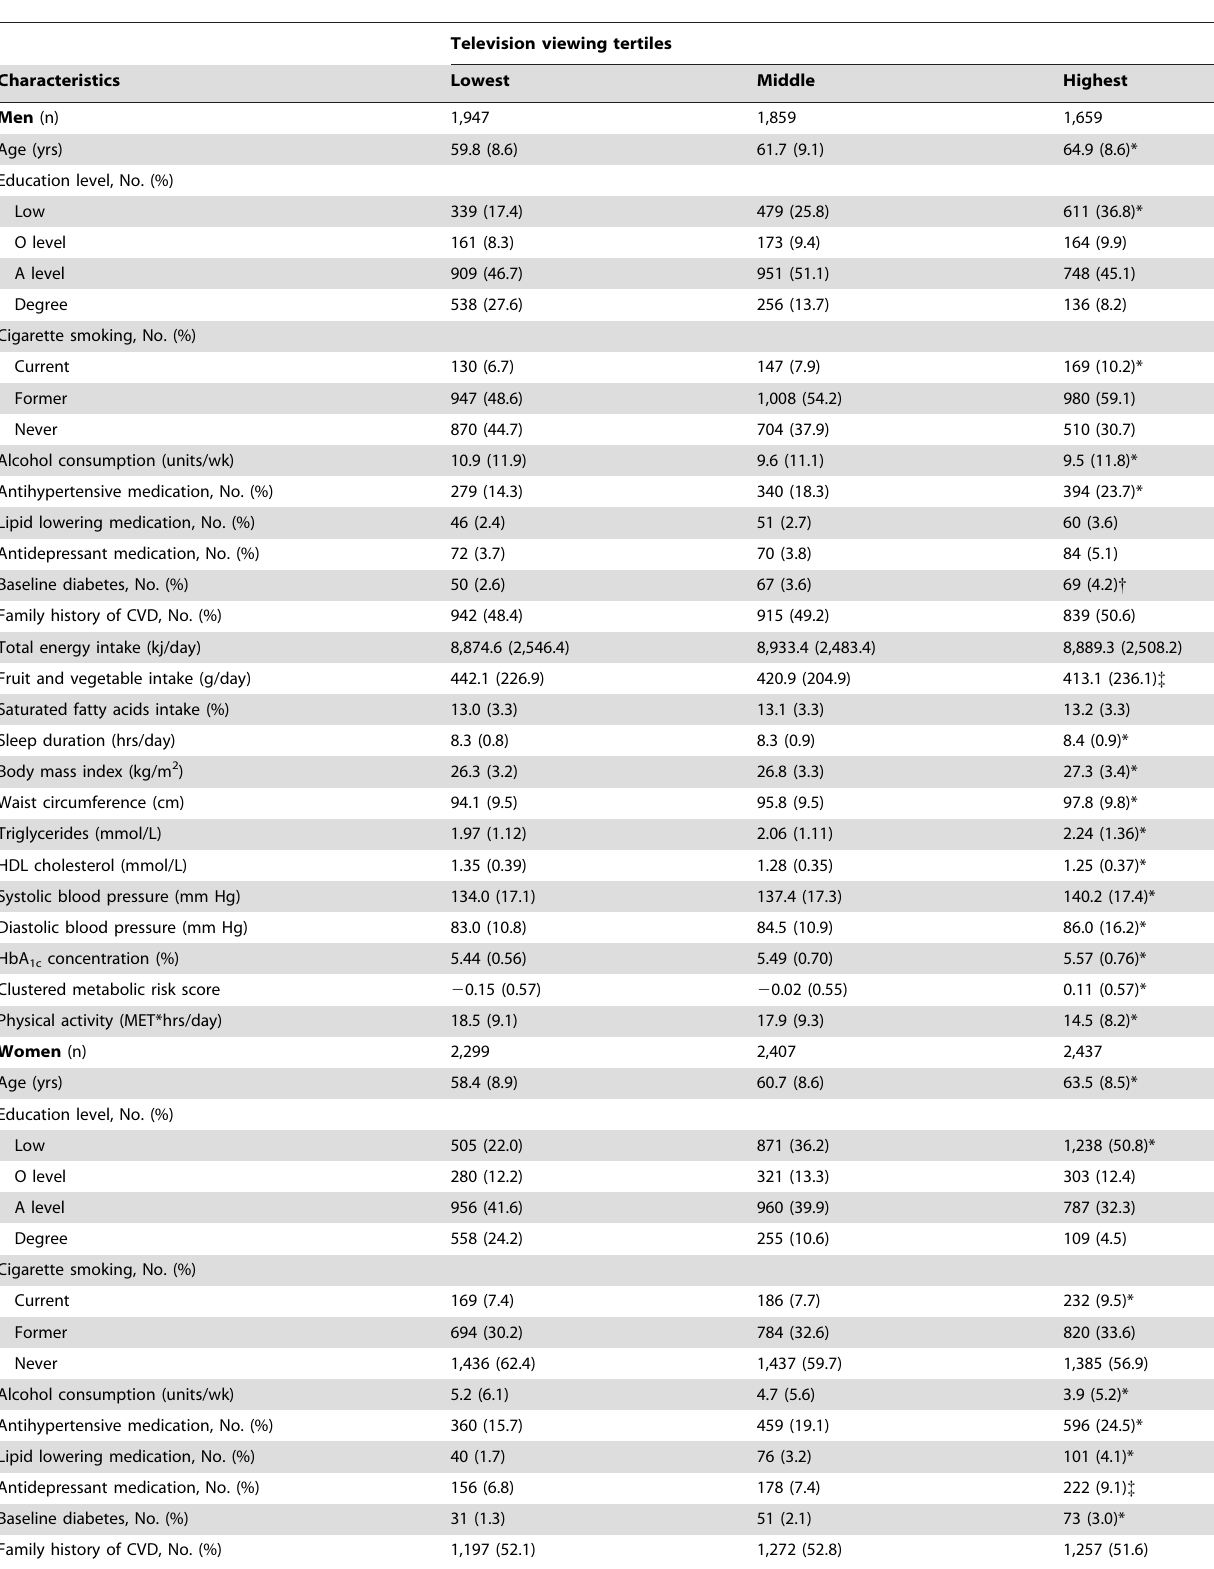
Table 2. Descriptive characteristics (mean (SD) or No. (%)) at baseline by television viewing tertiles (lowest: , 2.5, middle: 2.5–3.6, highest: . 3.6 hours/day) in 12,608 men and women in EPIC